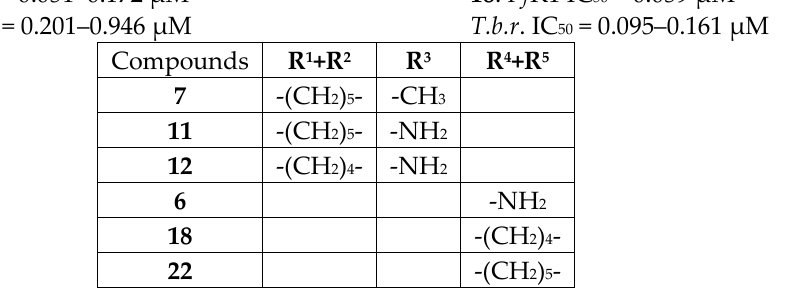
Figure 2. Most active compounds.